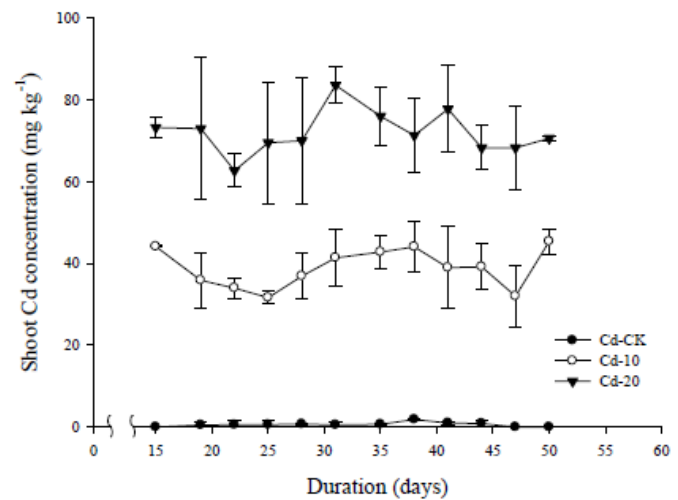
Figure 4. The dynamic change of Cd concentration (dry weight based) in the edible parts of pak choi grown in various Cd-contaminated soils. Replicates: n = 3.